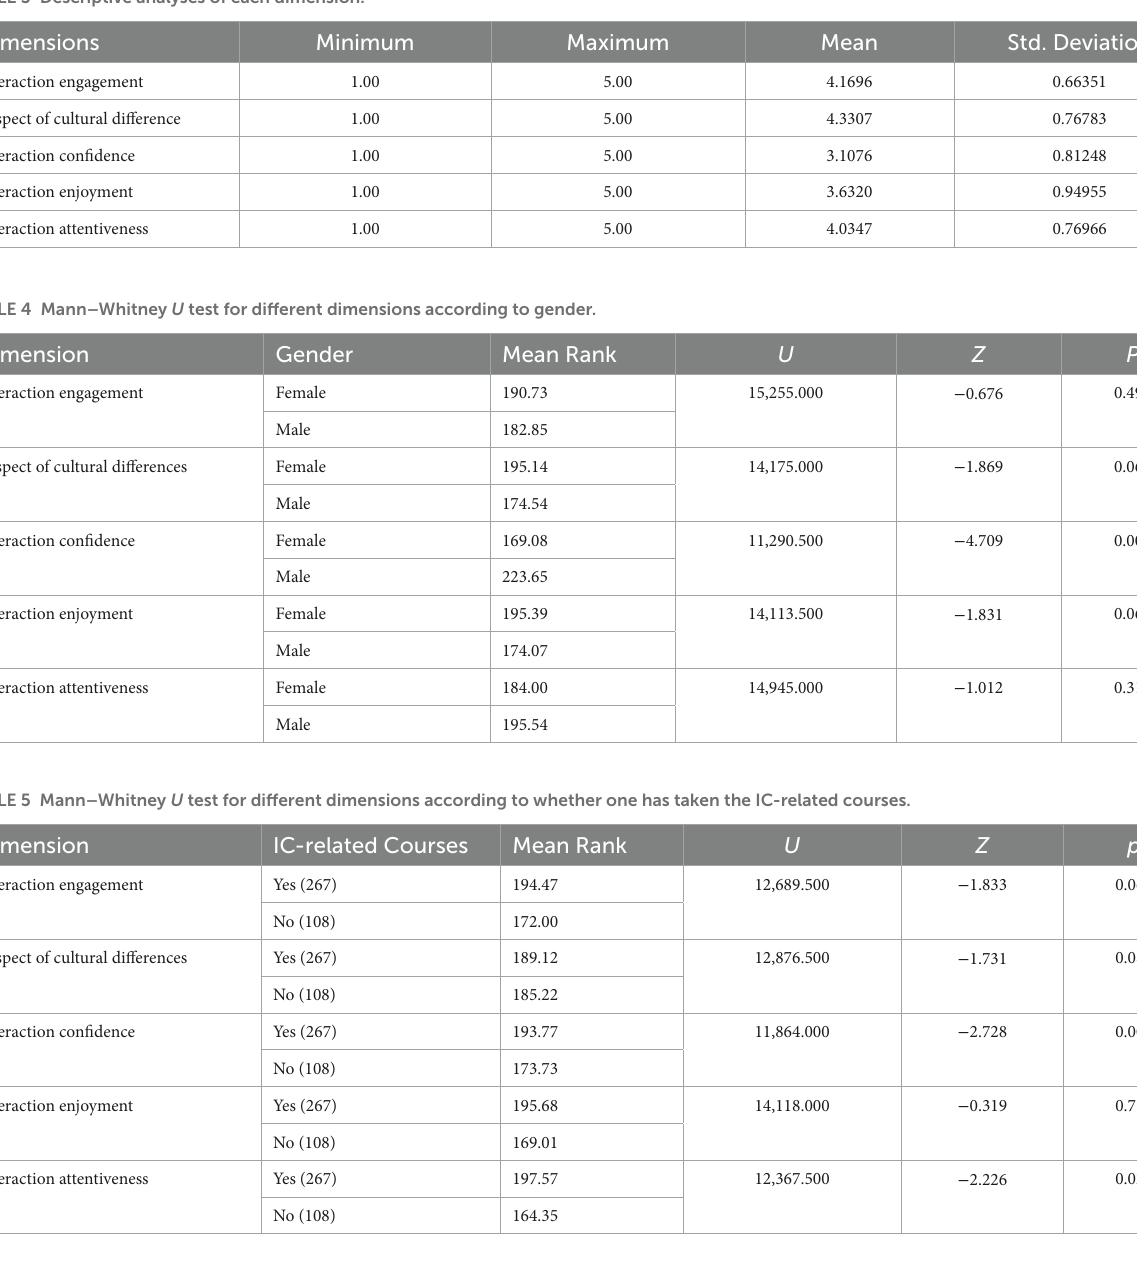
TABLE 3 Descriptive analyses of each